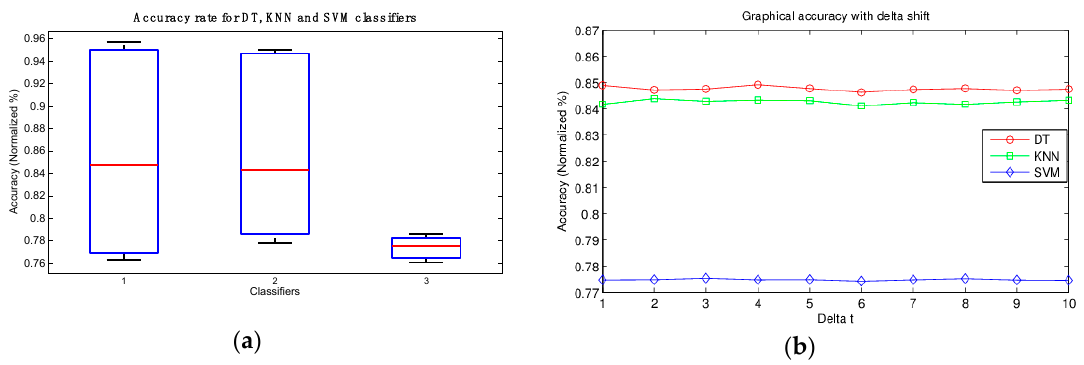
Figure 6. Graphical representation of accuracy rates: ( a ) for DT (1), KNN (2) and SVM (3); and ( b ) accuracy with delta movement.